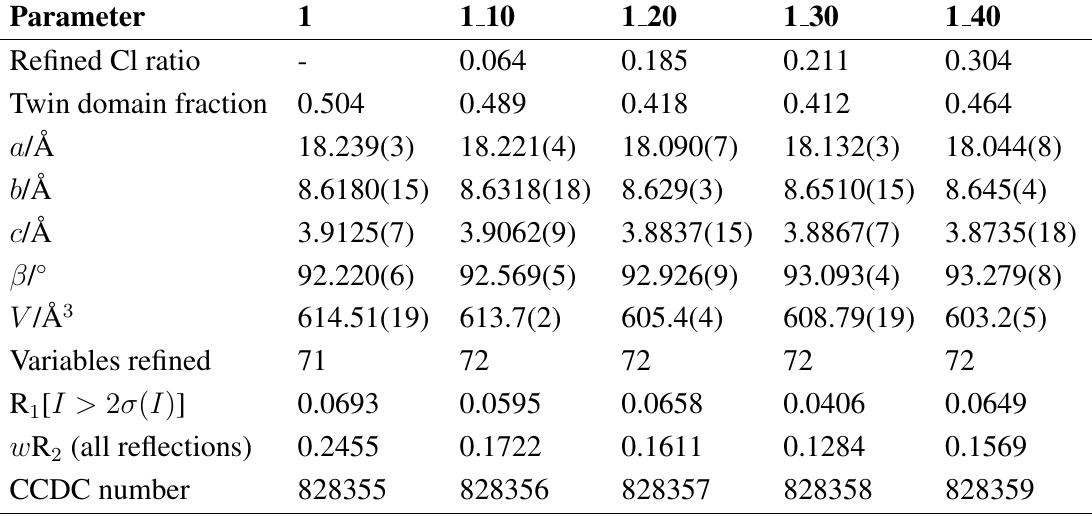
} 1 ] ( µ -Cl) py 2 − 2 x 2 x 2 ∞ / n with Z = 2 . 1